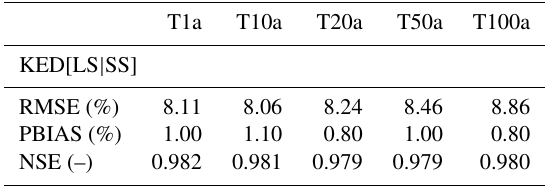
Table 11. Median cross-validation performance over 133 long se- ries (LS) stations for the final selected regionalisation method (KED[LS | SS]) at different return periods